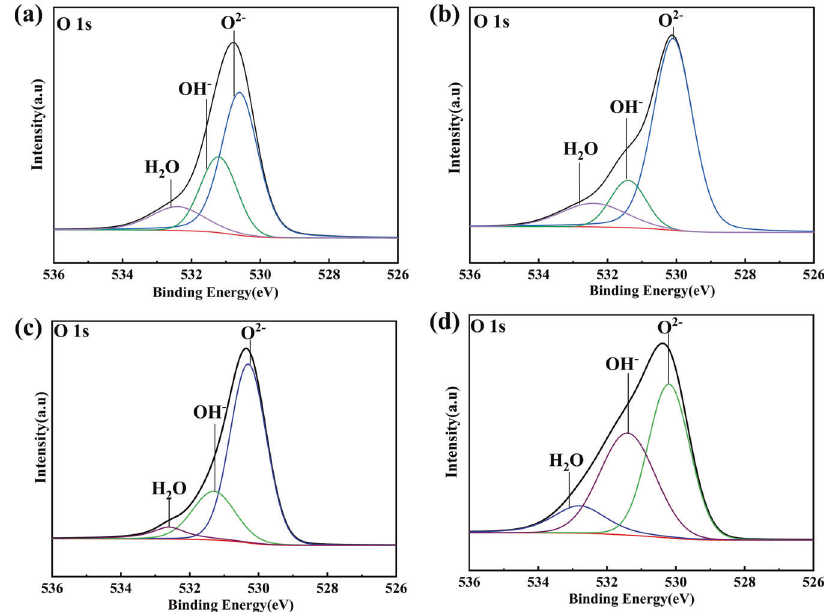
Fig. 7 The O 1s spectra for different alloys. a TC, b TCN, c TN, and d